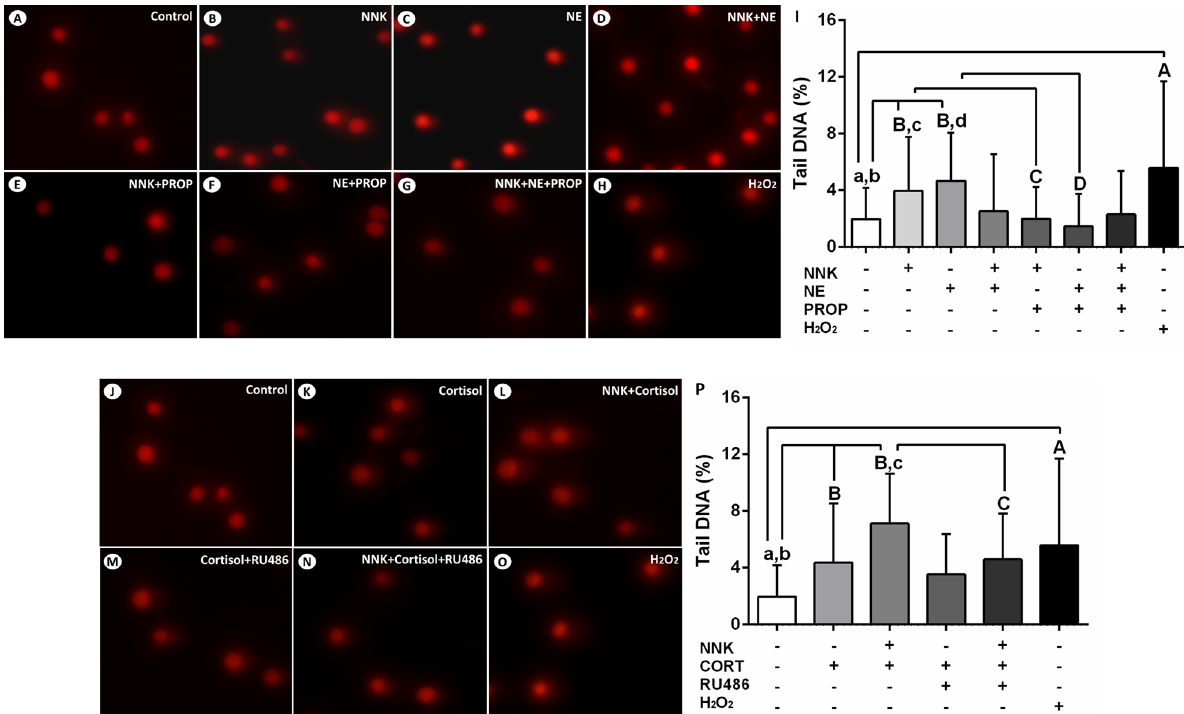
Figure 3. Stress hormones and NNK induce single-strand breaks and alkali-label side breaks in the DNA of oral epithelial cells. ( A ) Control. ( B ) NNK. ( C ) Norepinephrine. ( D ) NNK and norepinephrine. ( E ) NNK and propranolol. ( F ) Norepinephrine and propranolol. ( G ) NNK, norepinephrine and propranolol. ( H ) H 2 O 2 (positive control). ( I ) H 2 O 2 , NNK or norepinephrine increased DNA damage of NOK-SI cells. These effects were inhibited by the beta-adrenergic antagonist propranolol. Combined treatment of NNK and norepinephrine did not induce significant genotoxic effects. Cortisol enhanced the DNA damage of oral keratinocytes in the presence or absence of NNK. ( J ) Control. ( K ) Cortisol. ( L ) NNK and cortisol. ( M ) Cortisol e RU486. ( N ) NNK, cortisol and RU486. ( O ) H 2 O 2 (positive control). ( P ) H 2 O 2 , cortisol alone and glucocorticoid associated with NNK increased the DNA damage of NOK-SI cells. Glucocorticoid receptor antagonist RU486 reduced partially and totally the DNA damage induced by the cortisol alone and glucocorticoid combined with NNK, respectively. The results are expressed as the mean ± standard deviation (SD). Upper- and lower cases equal letters indicate a statistically significant difference ( p < 0.0001). H 2 O 2 = hydrogen peroxide. NNK = 4 (N-metil-N- nitrosamine)-1-(3-piridil)-butano-1-one). NE = norepinephrine. PROP = propranolol. CORT = cortisol. NNK, NE, PROP and RU486 were used at 10 µM. CORT was used at 100 nM. NOK-SI cells were exposed to NNK and/or stress hormones in the presence or absence of their antagonists for 72